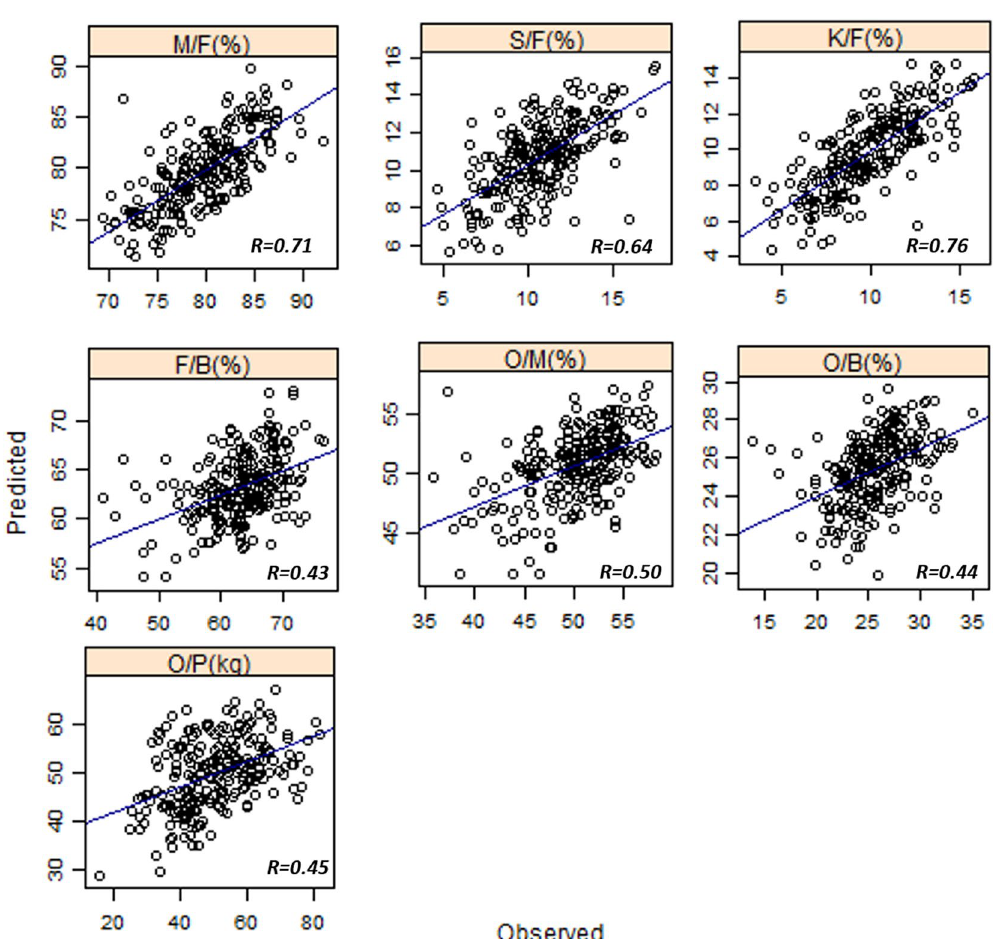
Figure 2. Representative plots for predicted trait values versus the observed trait values for all